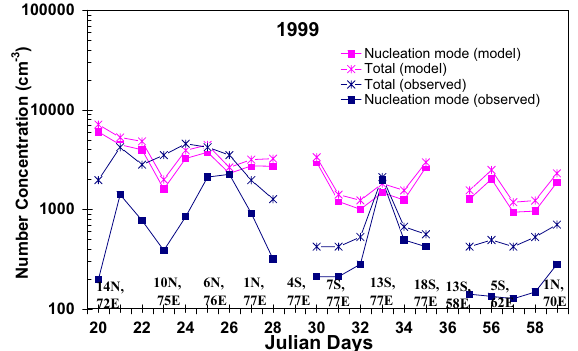
Fig. 6. Modelled and observed latitudinal variation of the total num- ber and nucleation mode concentrations of sulphate aerosol parti- cles along the Sagar Kanya cruise routes of IFP-99. Observations are from Kamra et al. (2003) and are decreased by 30% for the sake of comparing with sulphate only modelled number